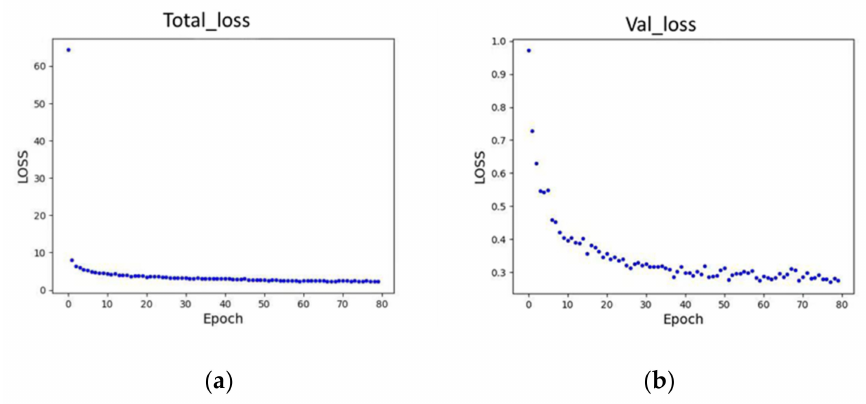
Figure 5. The change in network loss value: ( a ) the network total loss; ( b ) the network valid loss. The final predicted result of density was calculated by calculate the number prediction boxes. The training and testing progress were conducted in NVIDIA GTX1650SUPER with 16GB memory using the torch deep learning